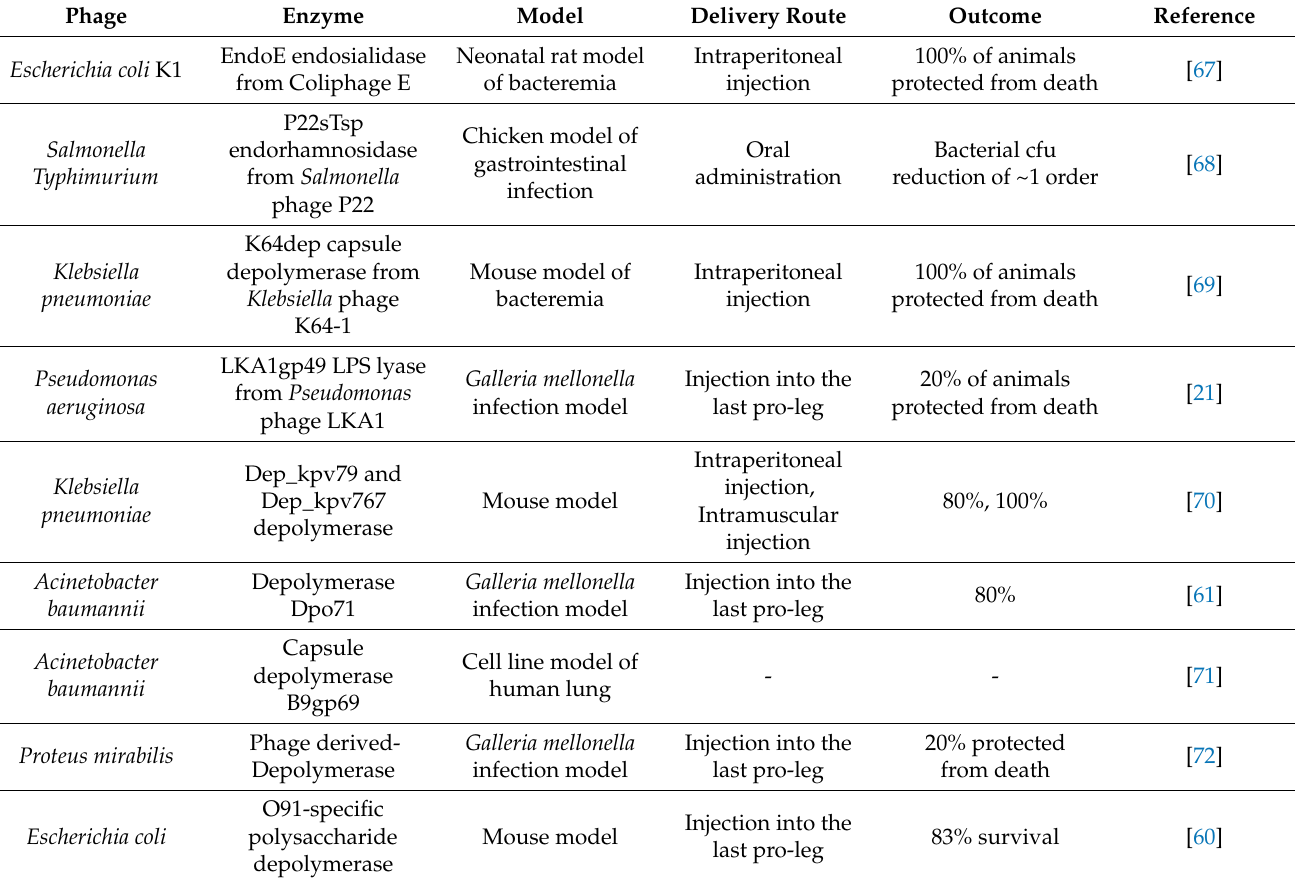
Table 1. The application of phage-derived depolymerases in animal